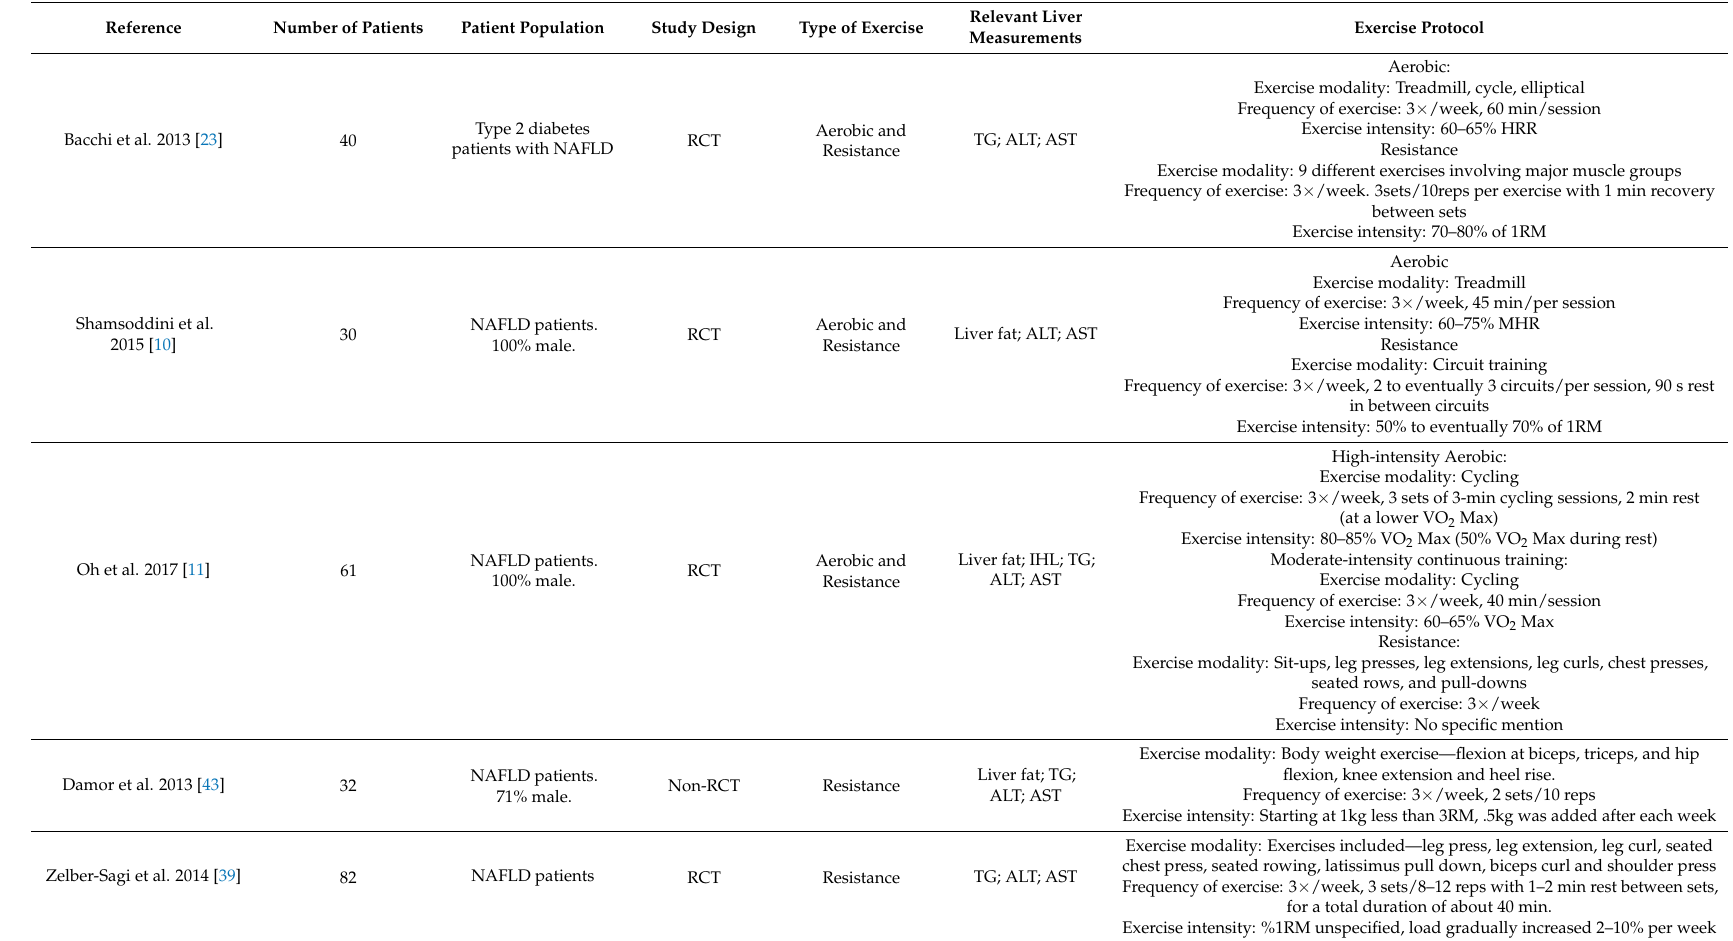
Exercise modality: Exercises included—leg press, leg extension, leg curl, seated chest press, seated rowing, latissimus pull down, biceps curl and shoulder press Frequency of exercise: 3 × /week, 3 sets/8–12 reps with 1–2 min rest between sets, for a total duration of about 40 min. Exercise intensity: %1RM unspecified, load gradually increased 2–10% per